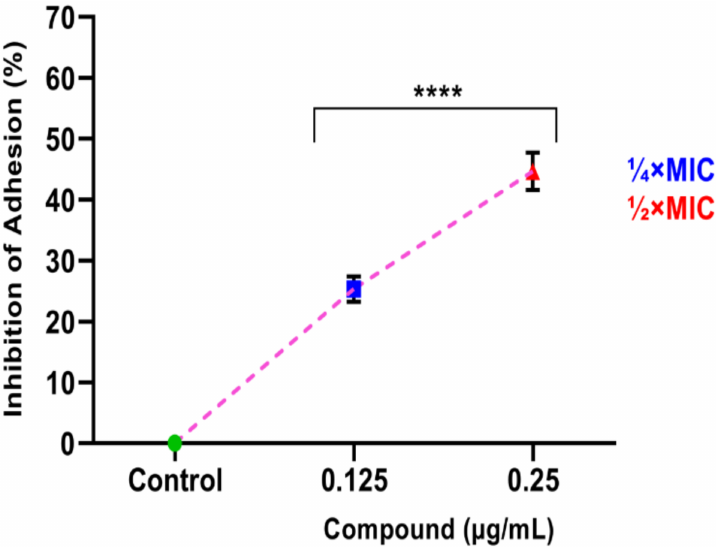
Figure 10. Effect of Ag-Cu bimetallic NPs on C. albicans adherence. Strain SC5314 cells were exposed to 1 / 4 MIC and 1 / 2 MIC of the test NP. Untreated cells (Control) represent 0% inhibition of adherence whereas, the adherence was found hindered in exposed C. albicans cells. **** p value <